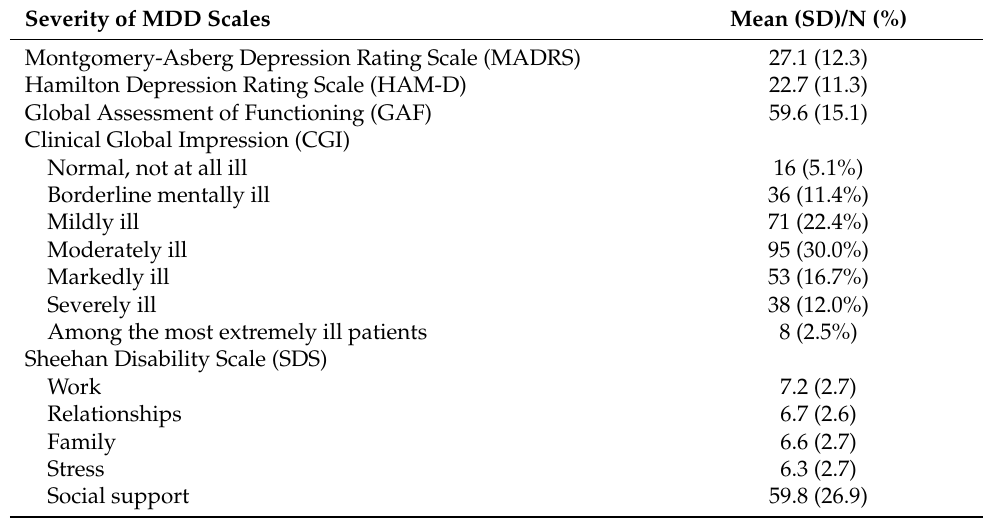
Table 3. Scales of MDD severity in 317 study subjects recruited until 1 July